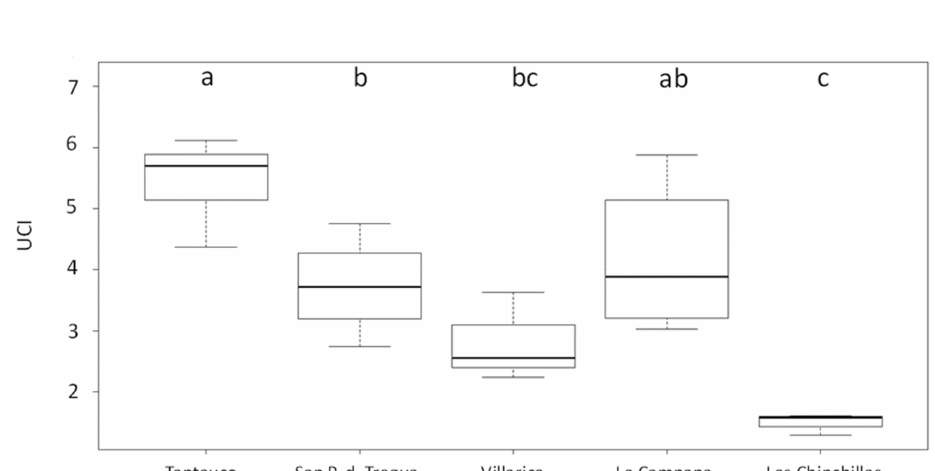
Figure 7. Box-and-whisker plot of the understory layer complexity, assessed using the understory complexity index (UCI) for each site. Different letters indicate significant differences among the means according to ANOVA and Tukey post hoc test. For the number of scans per site see Table